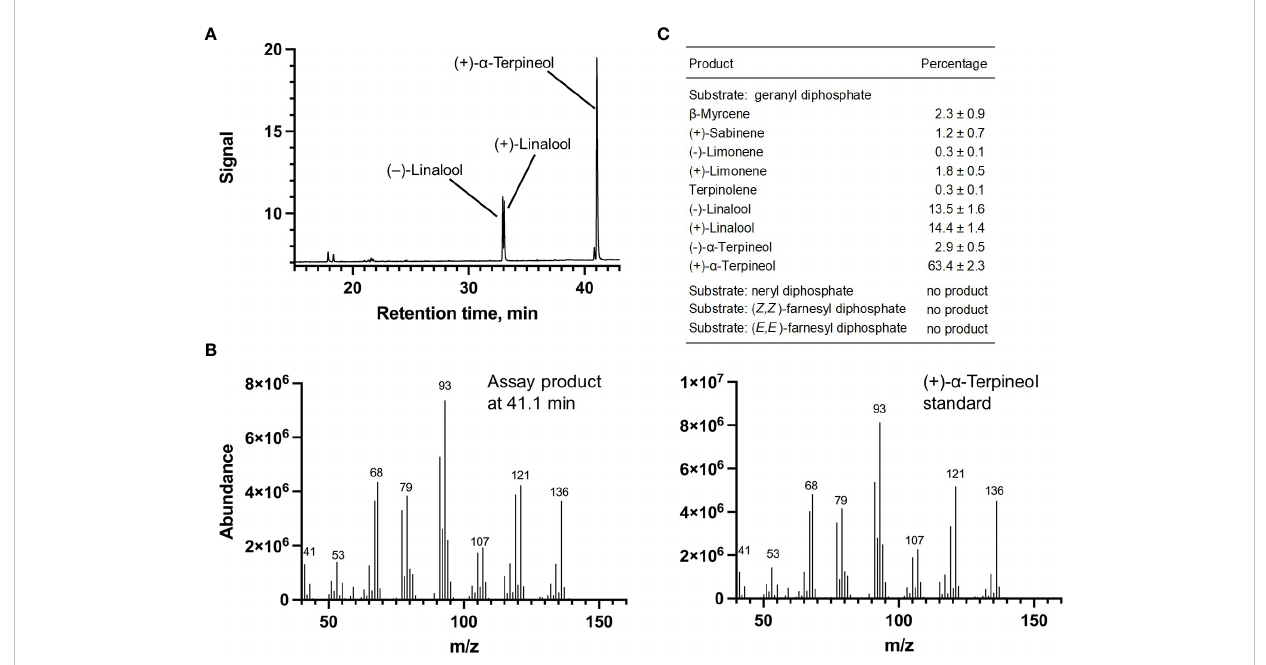
FIGURE 5 Characterization of M. longifolia CMEN 585 candidate Ml_15999. (A) GC chromatogram with annotation for major peaks; (B) mass spectrum of the main enzymatically generated product and the matching authentic standard [(+)- a -terpineol); and (C) tabulated product pro fi